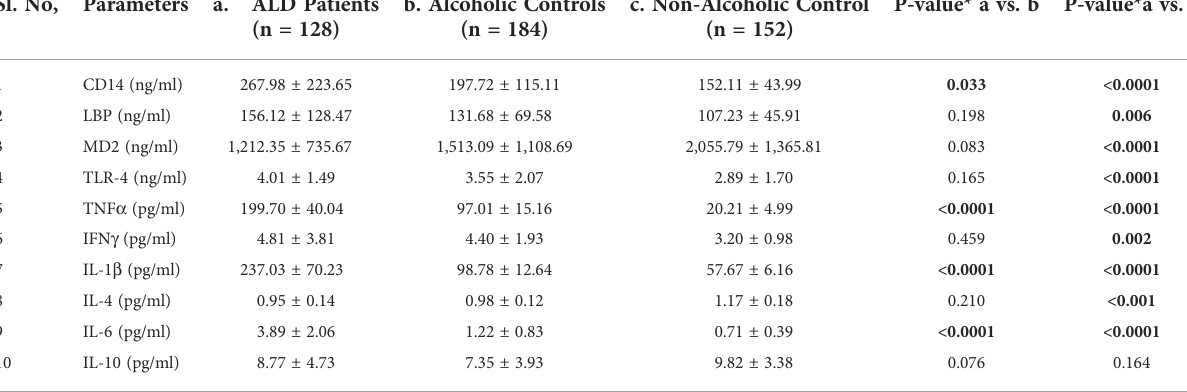
TABLE 4 Expression of CD14 and other pro- and anti-in fl ammatory cytokines in sera of individuals of the ALD, ALC, and NALC groups. Sl. No, Parameters a. ALD Patients (n =